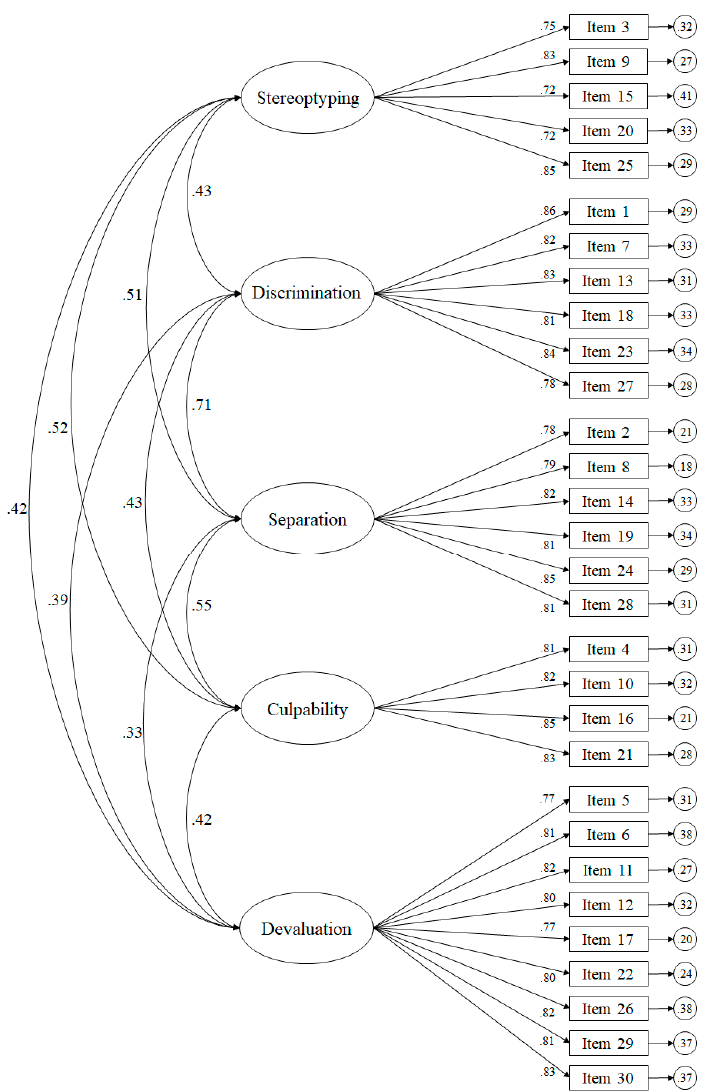
Figure 1. Confirmatory factor analysis of the 30-item scale in the Spanish context. The ellipses represent the factors and the rectangles represent the different items. The residual variances are shown in the small circles.